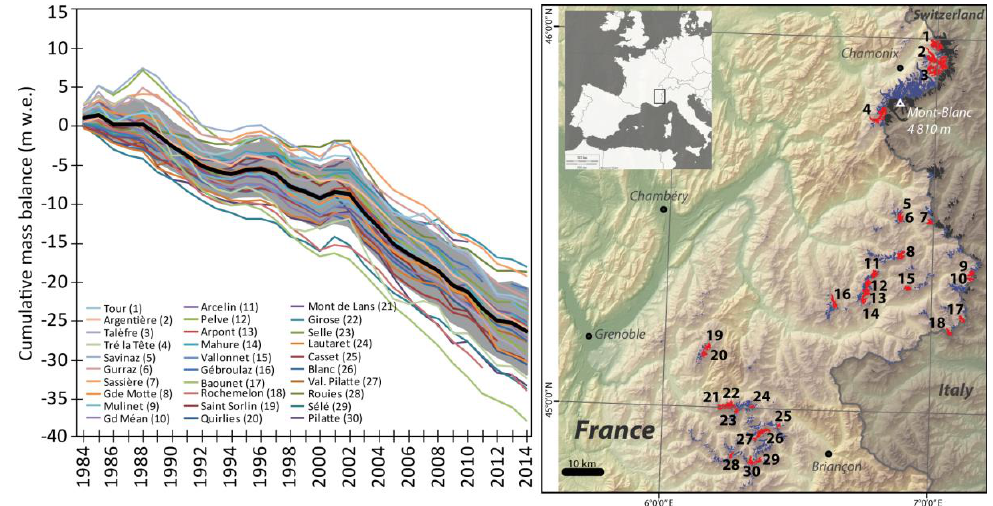
Figure 2. Cumulative glacier-wide mass balance time series for 30 glaciers in the French Alps (1983–2014), quantified from the end-of-summer snow line. The black curve on the graph is the average of the 30 glaciers, and the grey area shows the ± 1 standard deviation interval. Numbers in brackets after the glacier name refer to the map on the right. Adapted from Rabatel et al. [9]. Rabatel et al. [9] also considered the impact of using an intermediate DEM when the study period is long (e.g., several decades). Indeed, to quantify the average annual SMB over the entire period by DEM differencing, the mean surface area of the glacier is generally taken as the arithmetic mean of the initial and final areas. This assumes that surface area and SMB trends are linear, which is